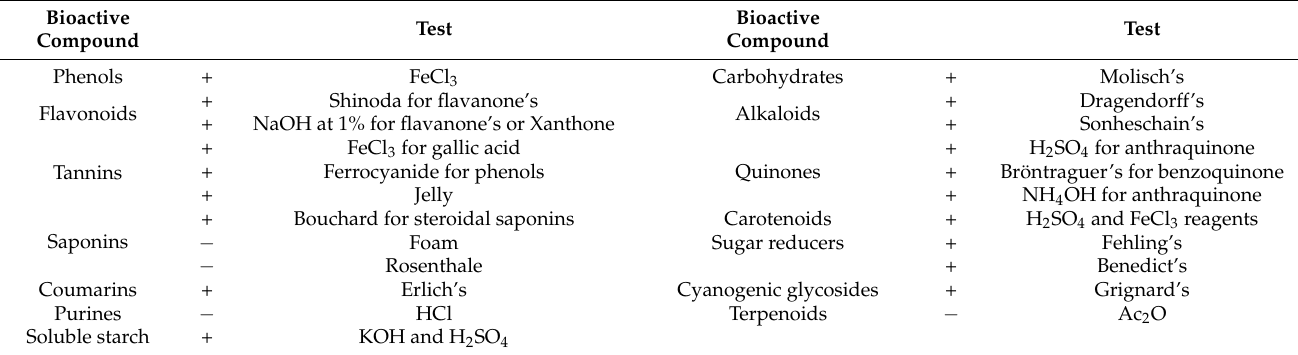
Table 1. Secondary metabolites (“+” = present; “ − ” = absent) in Moringa oleifera leaf ethanolic extract. Bioactive